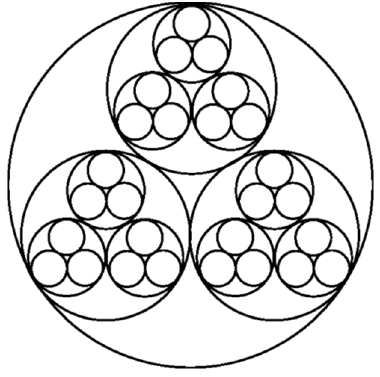
Figure 2. Microstructure of wool.